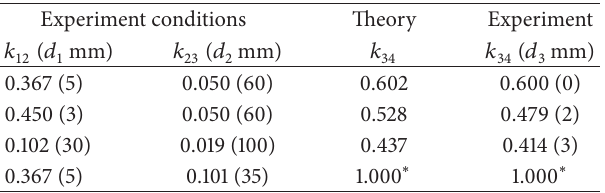
Table 4: Theoretical and experimental values of 𝑘 23